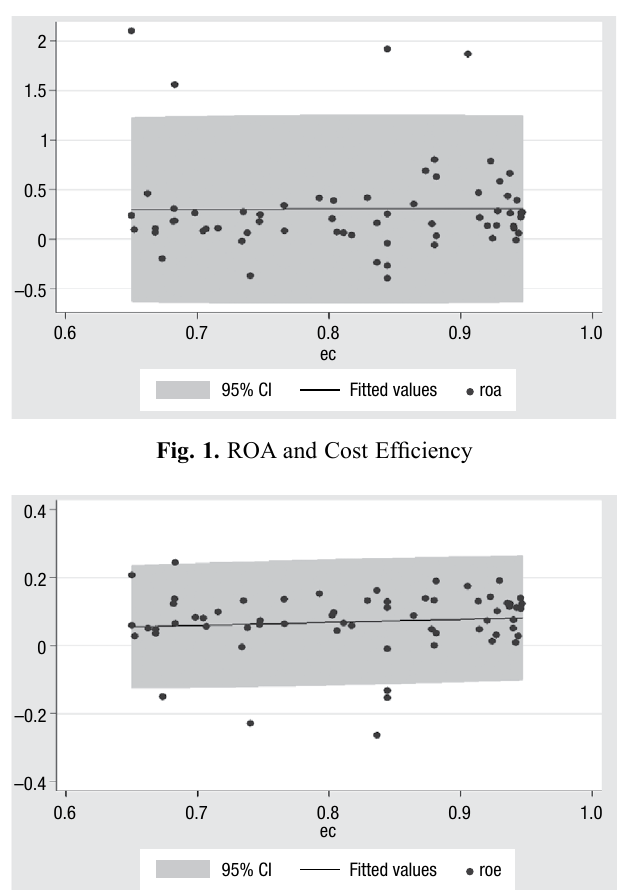
Fig. 2. ROE and Cost Efficiency